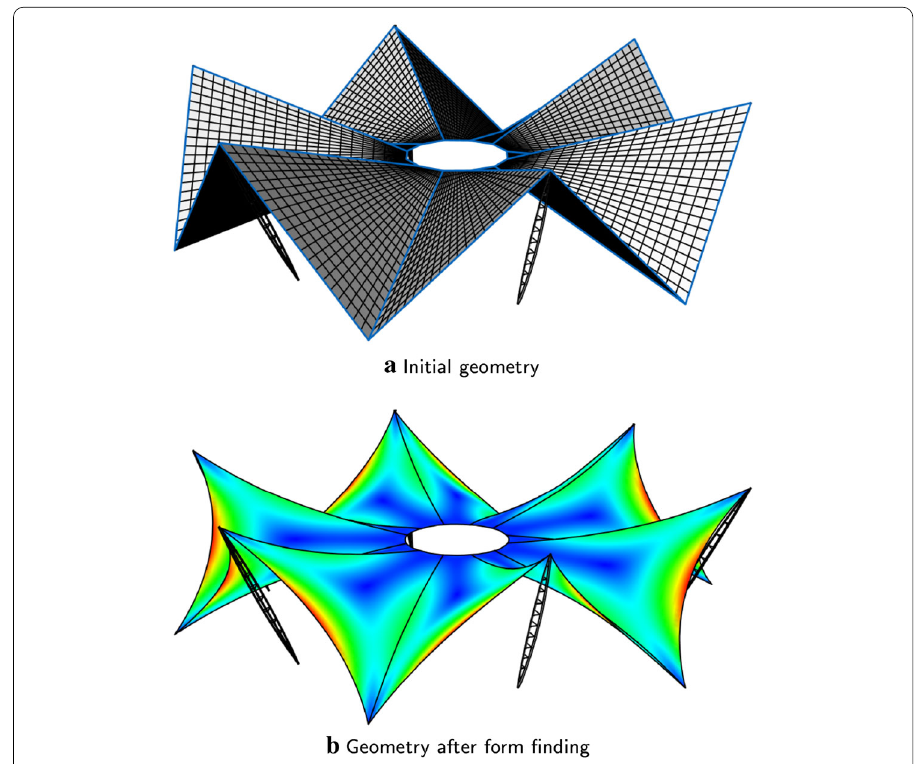
Fig. 16 Form finding analysis of the Sternwellenzelt by Frei Otto: a CAD model with interacting surface and curve (blue) elements and b resulting displacement